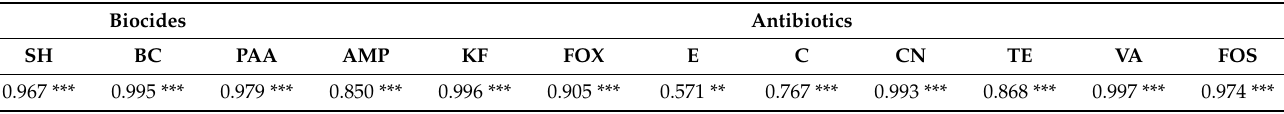
Table 6. Coefficients of correlation between MIC and MBC values of 12 antimicrobials in eight strains of Listeria monocytogenes